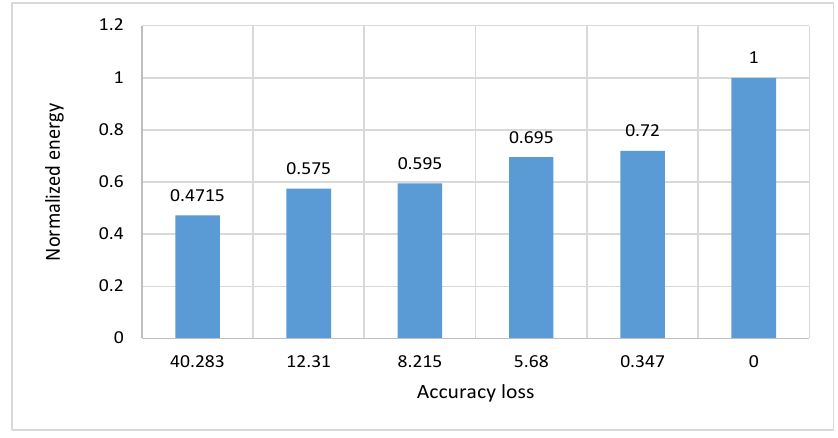
Figure 12. SVHN: Energy levels that the proposed EANN system uses to adapt to the given energy budget. Table 2. Power and accuracy regions for the SVHN dataset. Normalized Energy Accuracy Loss